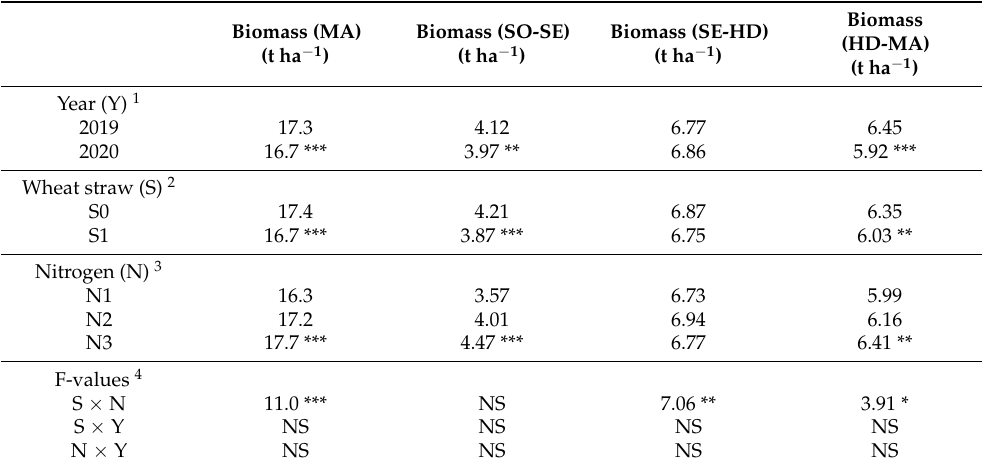
Table 3. Biomass accumulation as affected by wheat straw returning (S0 or S1; n = 18), nitrogen (N1, N2, or N3; n = 12), and year (2019 or 2020; n = 18).